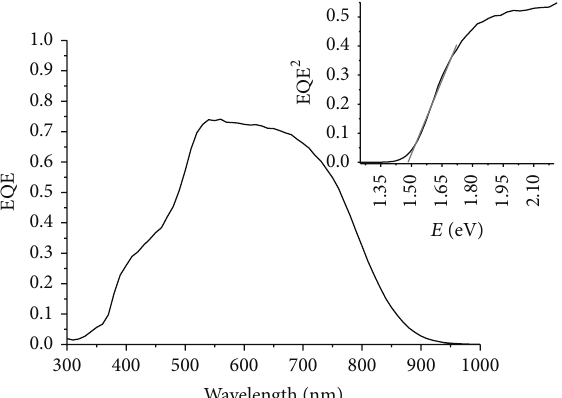
Figure 3: EQE of a CdS/CZTS solar cell based on the Cu-poor/Zn- rich CZTS layers examined in this work. The determination of the absorber bandgap obtained by interpolation of the low energy part of the EQE curve is reported in the inset.